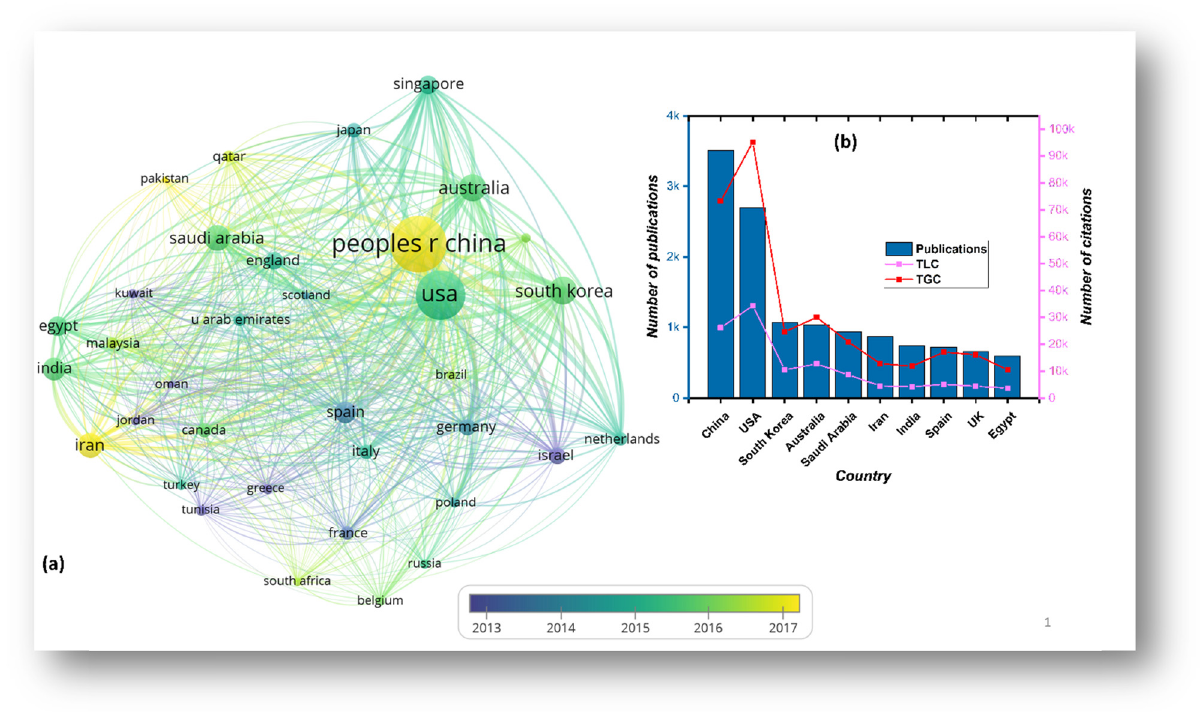
Figure 6: ( a ) Region - based distribution of desalination publications between 2000 and 2020; ( b ) top 10 contributing countries and their TLC and